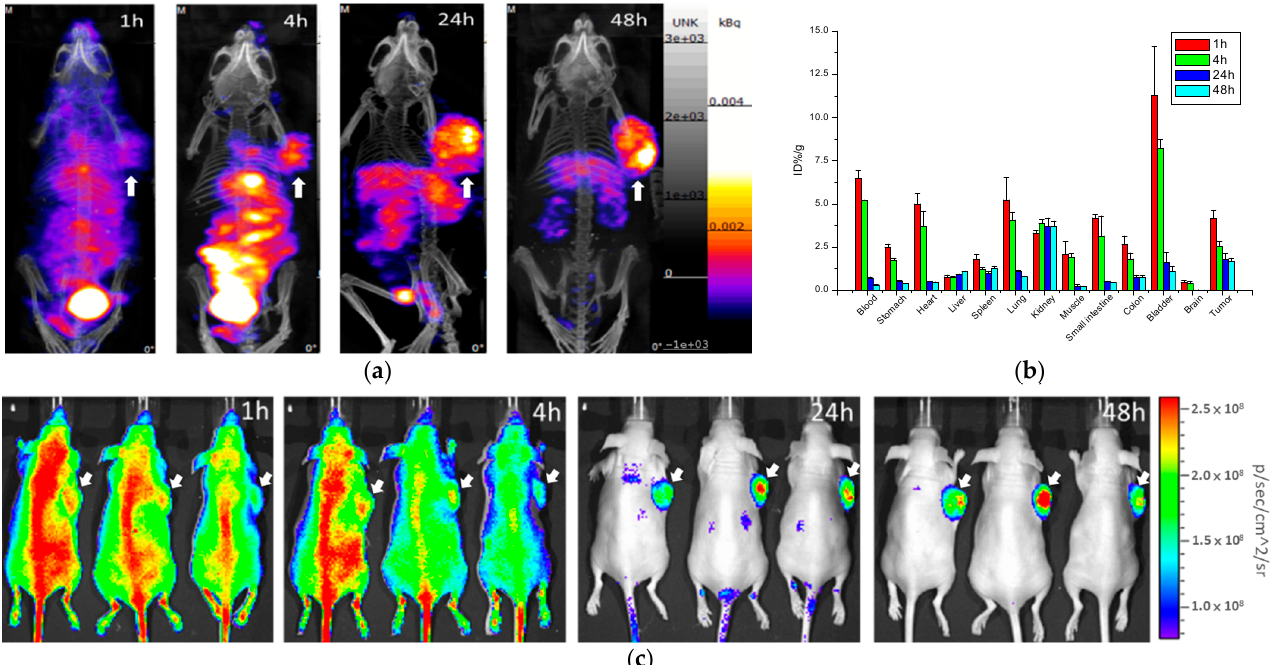
Figure 3. ( a ) SPECT/CT images, ( b ) biodistribution, and ( c ) NIRF images of 111 In-DOTA-NIR790 in mice bearing subcutaneous 4T1 breast tumors ( n = 3 at each time point). Arrow indicates tumor.